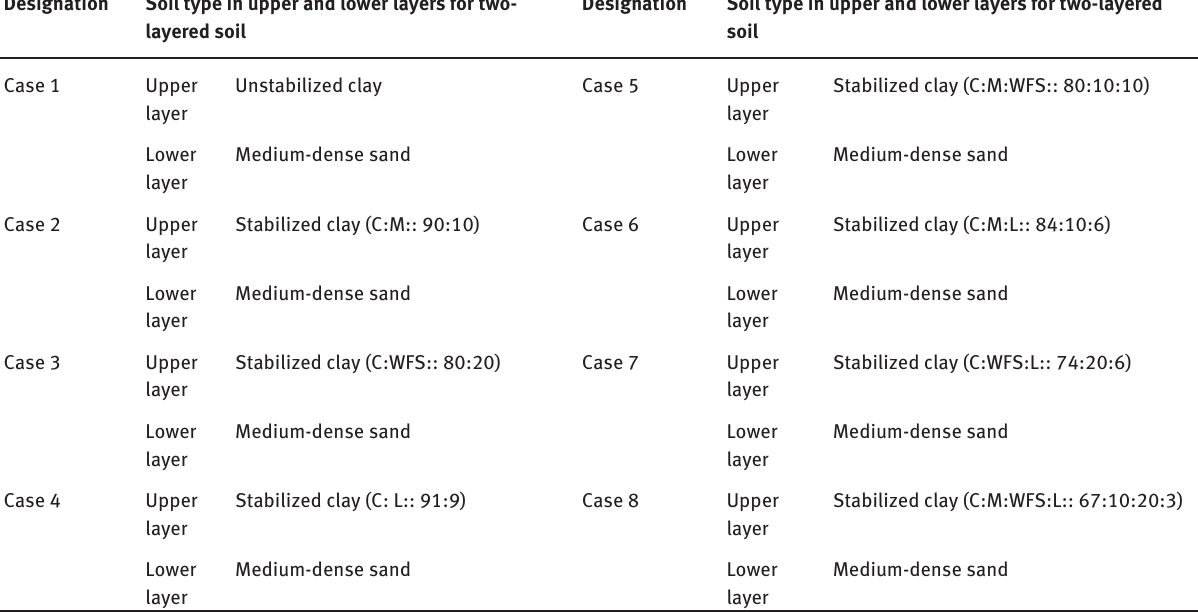
Table 1: Designation and details of type of soil in upper and lower layers under both types of footings in two-layered soils.